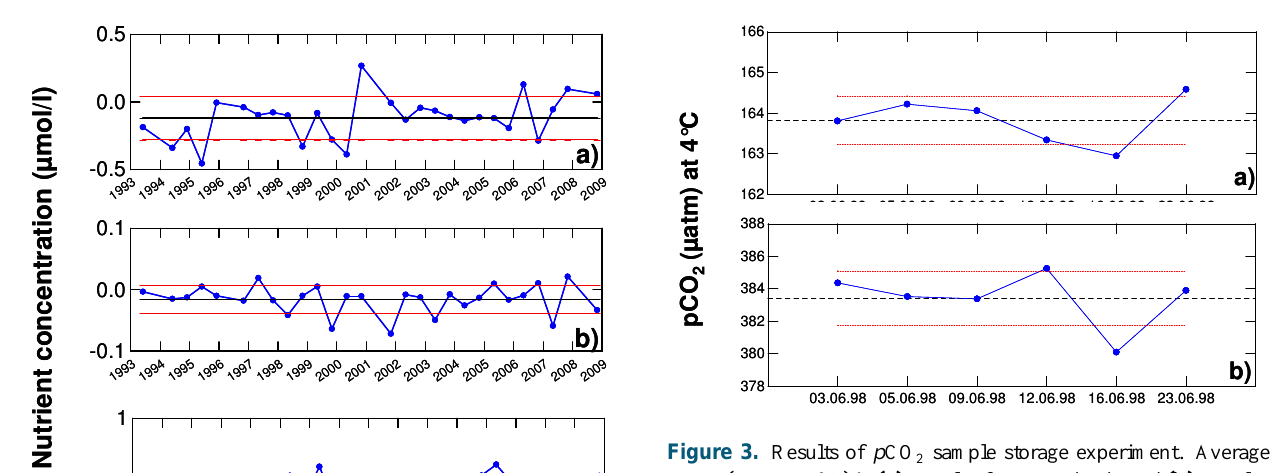
Figure 3. Results of p CO 2 sample storage experiment. Average p CO 2 ( µ atm at 4 ◦ C) in (a) samples from 5m depth, and (b) samples from 200m depth. The average concentrations for the storage experiment are shown with a black slashed line and their standard deviations are shown with red dotted